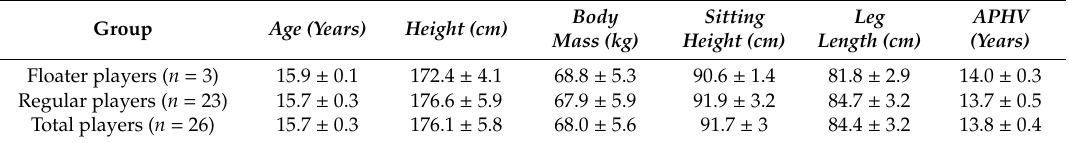
Table 1. Characteristics of the